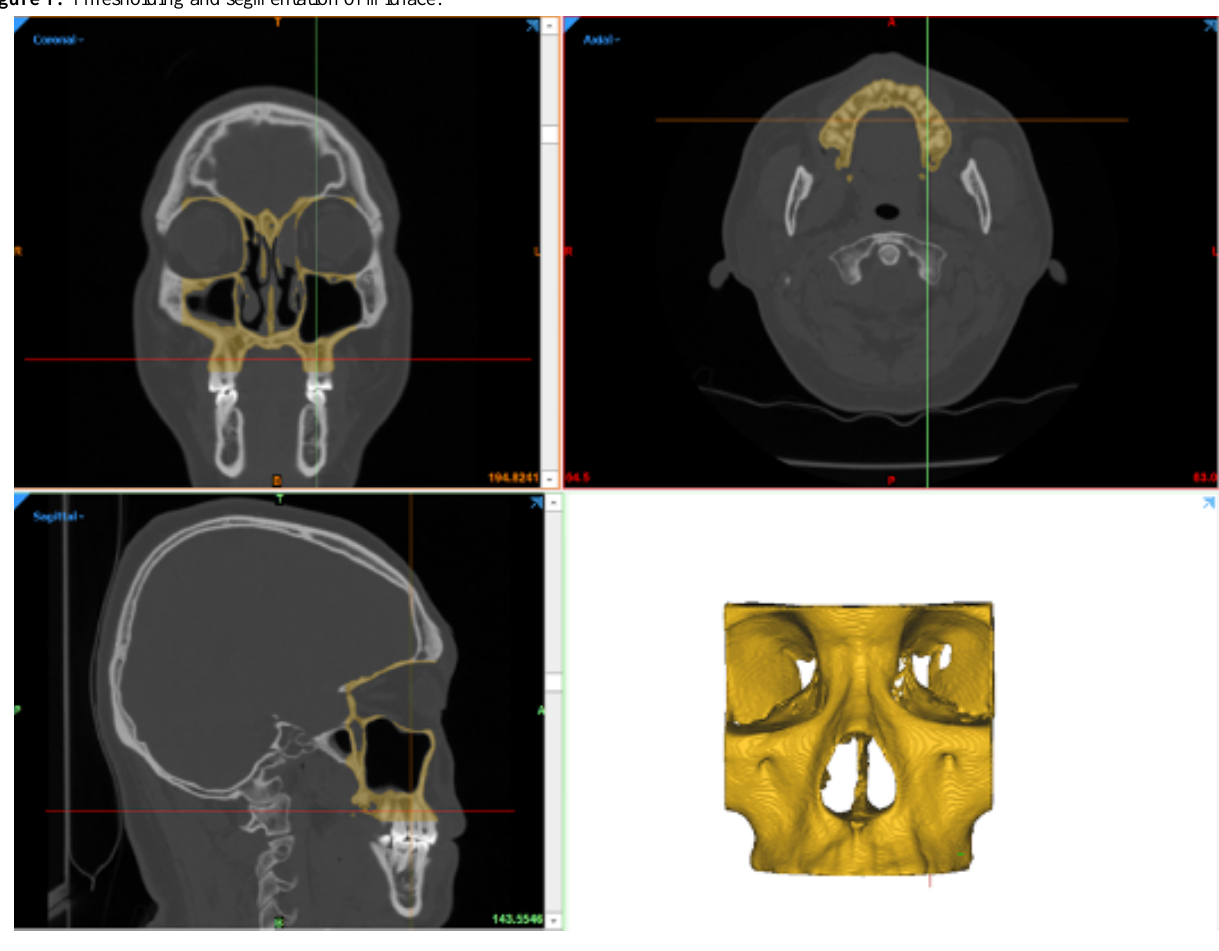
Figure 1. Thresholding and segmentation of